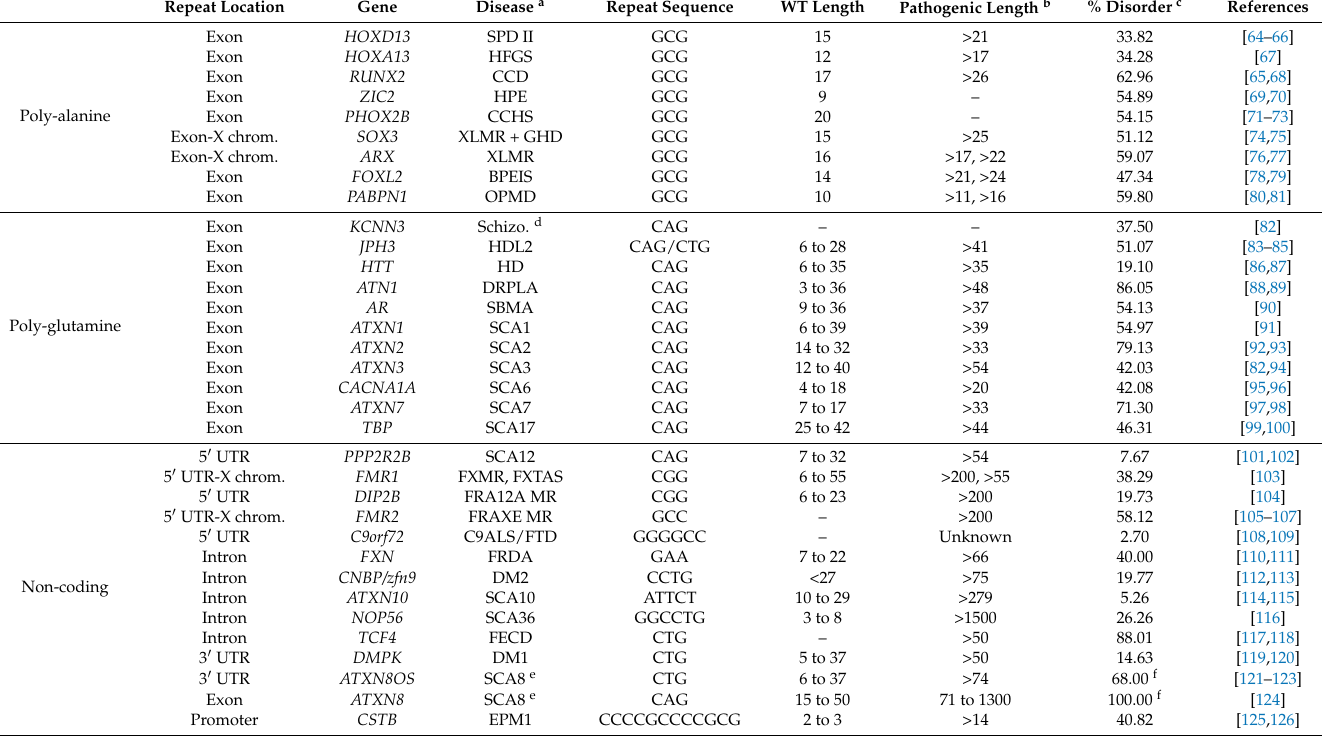
Table 1. Major characteristics of genes with pathological repeat expansions and proteins they